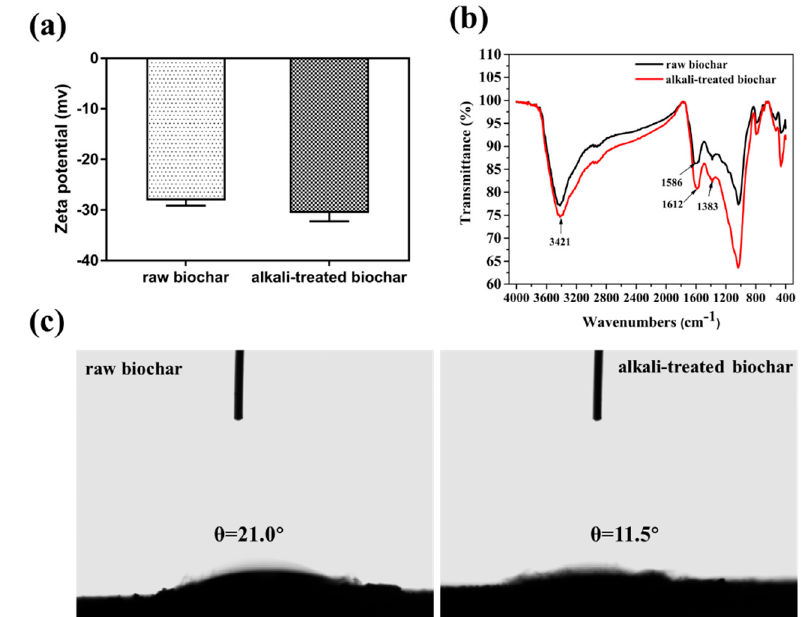
Figure 1. Zeta potential characterization of biochar before and after alkali treatment ( a ); FT-IR spectrum of biochar before and after alkali treatment ( b ); contact angle between biochar and water before (left) and after (right) alkali treatment ( c ).